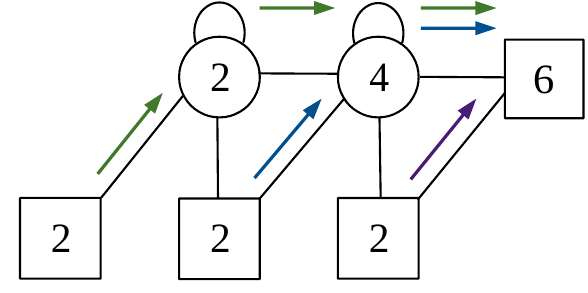
Figure 15 . Operators contributing to (cid:5) in the N = 3